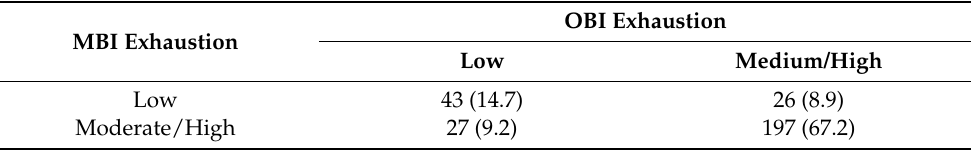
Table 5. 2 × 2 contingency table for exhaustion analyzed by the Maslach Burnout Inventory (MBI) or the Oldenburg Burnout Inventory (OBI).